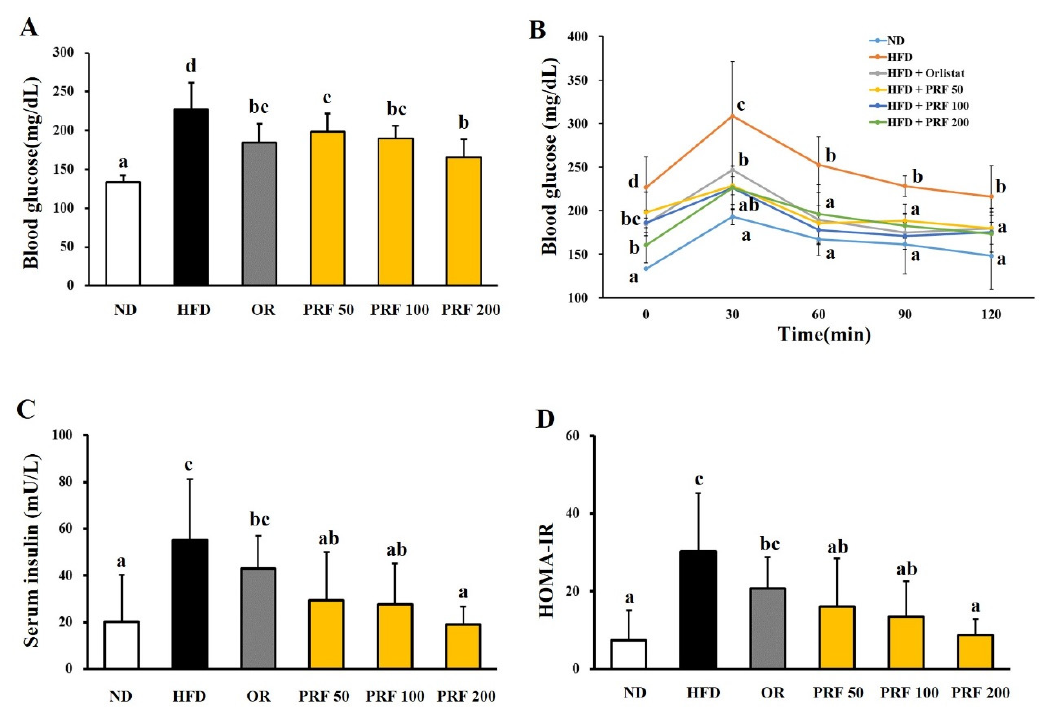
Figure 3. Effect of PRF on glucose homeostasis in HFD-induced obese mice. The mice were fasted for 8 h before measuring blood glucose. ( A ) Fasting blood glucose levels; ( B ) oral glucose tolerance test (OGTT); ( C ) serum insulin levels; ( D ) HOMA-IR index. ND, normal diet; HFD, high-fat diet; OR, HFD + 15.6 mg of orlistat; PRF 50, PRF 100, and PRF 200, HFD + 50, 100, and 200 mg of PRF, respectively. The results are expressed as the means ± SDs ( n = 7). The values with different letters (a–d) are significantly different ( p < 0.05) from each other according to one-way ANOVA and Duncan’s multiple-range test.